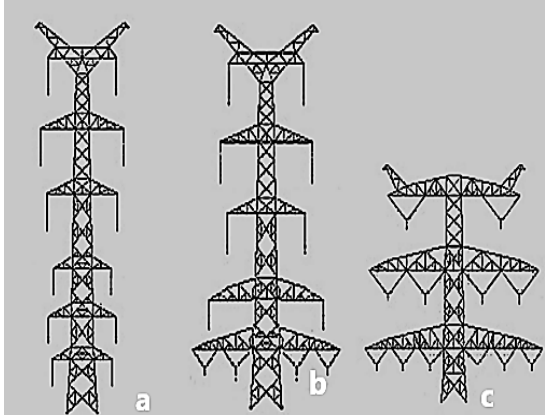
Figure 25. Typical tower 500/220 kV mixed ‐ voltage quadruple ‐ circuit [80], ( a ) vertical tower, ( b ) d ‐ type tower, and ( c ) e ‐ type [80].